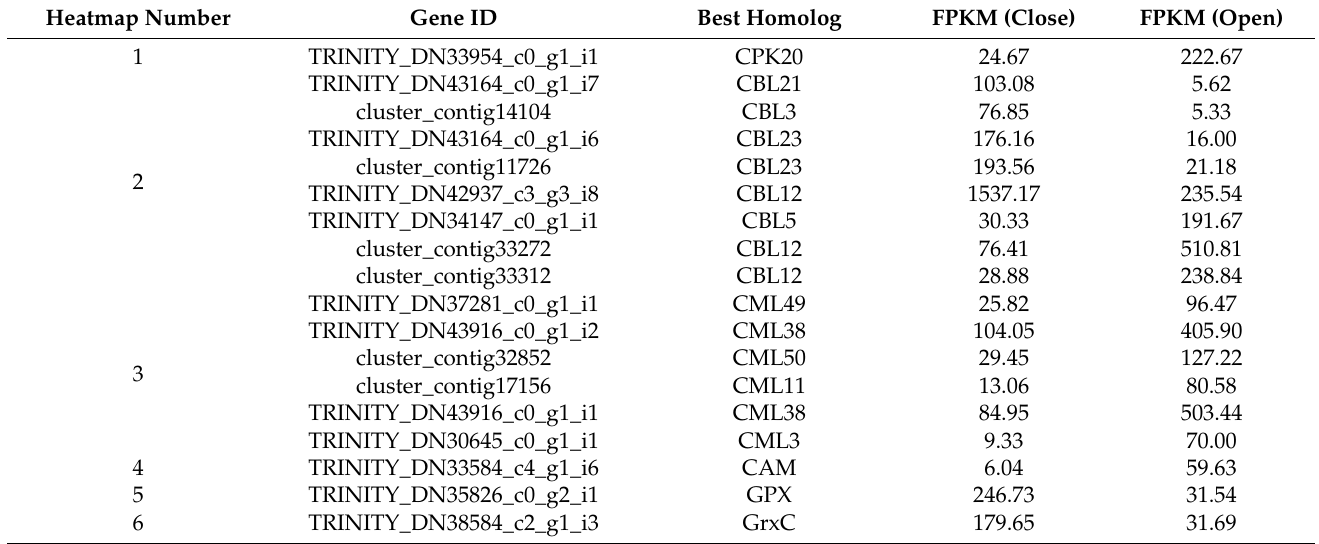
protein and is thus highly expressed in the CP stage, just as HY5 is (Figure 4B and Table 2). Table 1. Ca 2+ signaling and ROS signaling pathway gene expression levels (corresponding to Figure